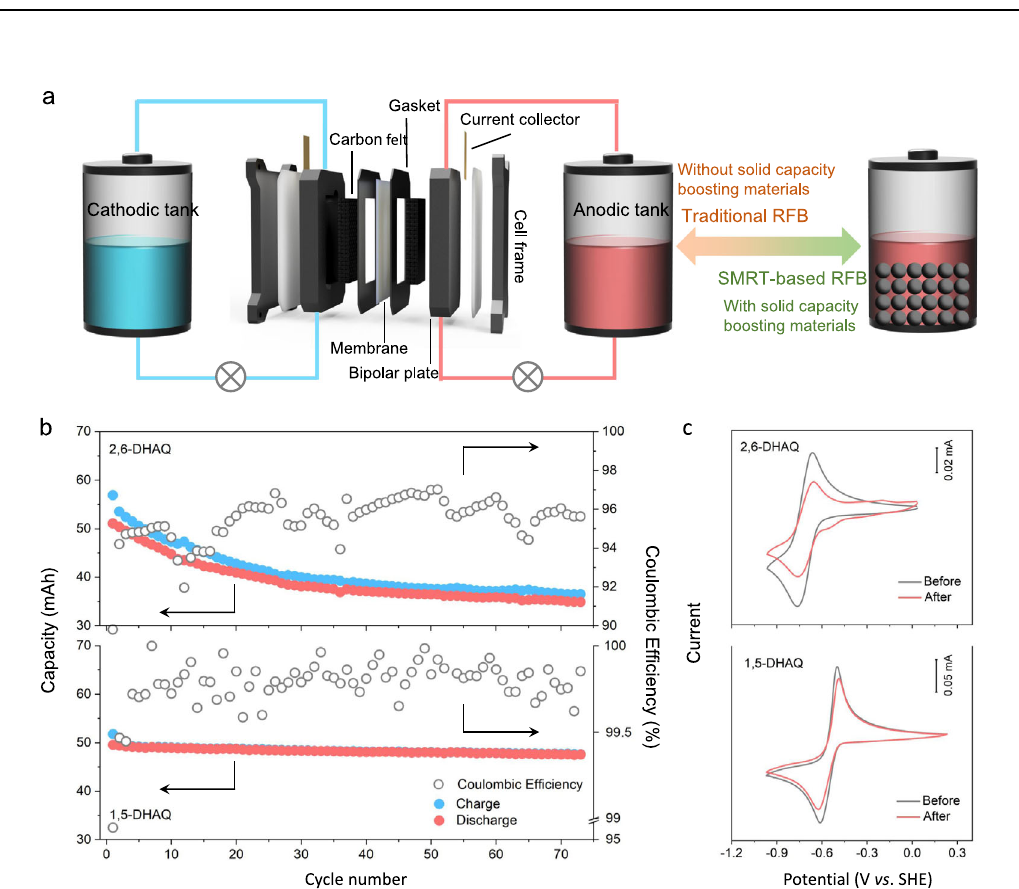
Fig. 3 | Setup of the batteries and electrochemical performances of conven- tional RFBs. a Schematic illustration of the con fi guration of a conventional RFB withliquidelectrolytes fi lledinbothtanksandthatofaSMRT-basedRFBwithsolid capacity-boostingmaterialloadedintheanodictank.Theelectrodeactiveareawas 5cm 2 . b Coulombicef fi ciencyandcapacityretentionfortheanolyte-limitedDHAQ|